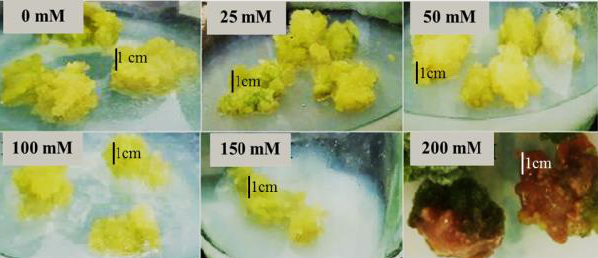
Figure 3. Callus phenotype of Carum copticum under salt treatment. The photographs were taken 4 weeks after the start of treatment. Sidebar in each picture shows 1 cm.